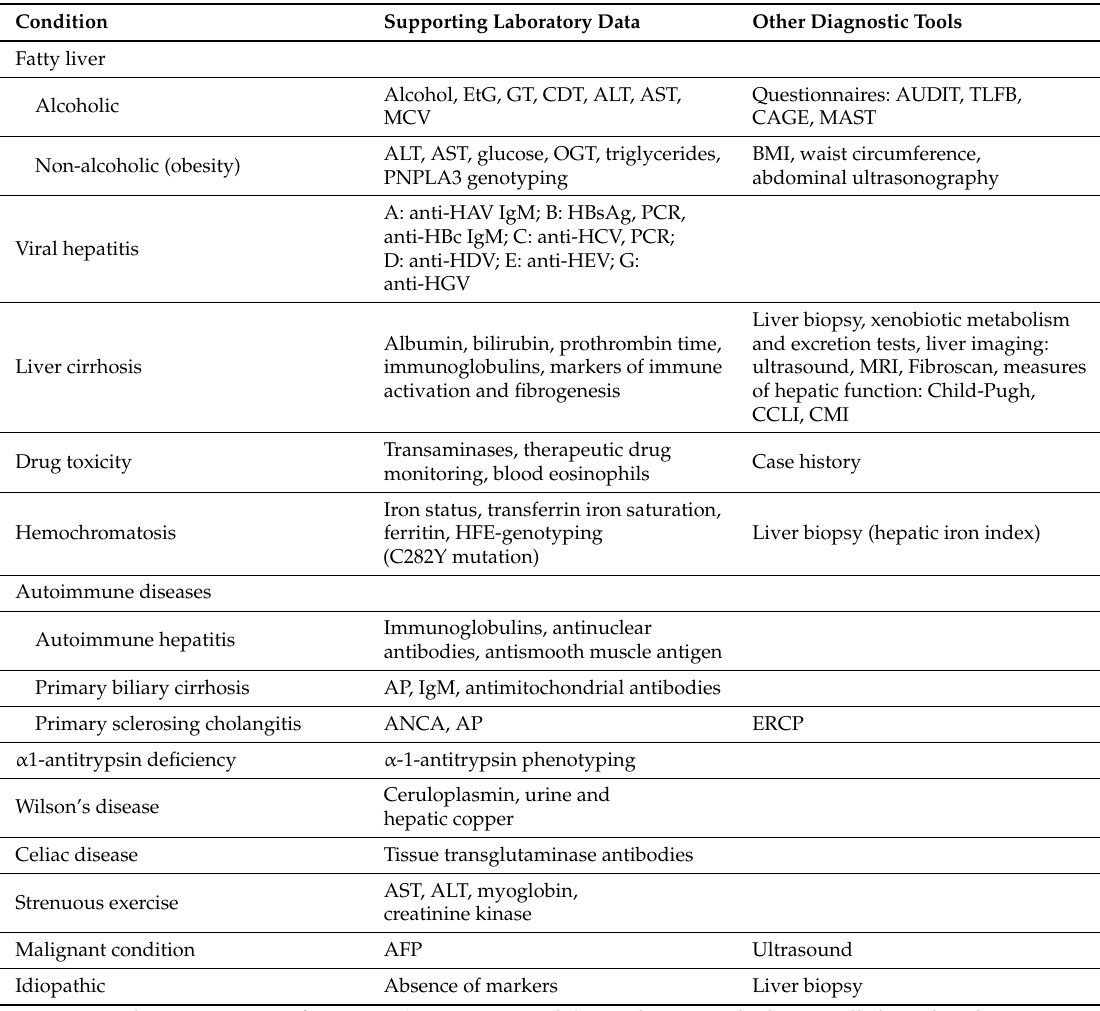
Table 2. Biomarker-based differential diagnosis of abnormal liver